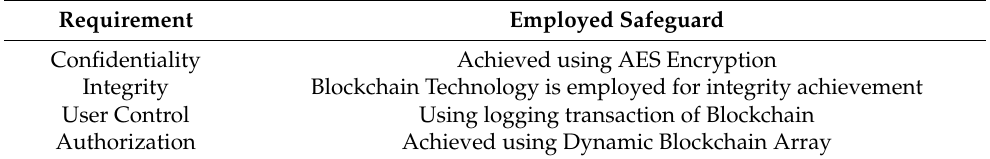
Table 1. Security requirements